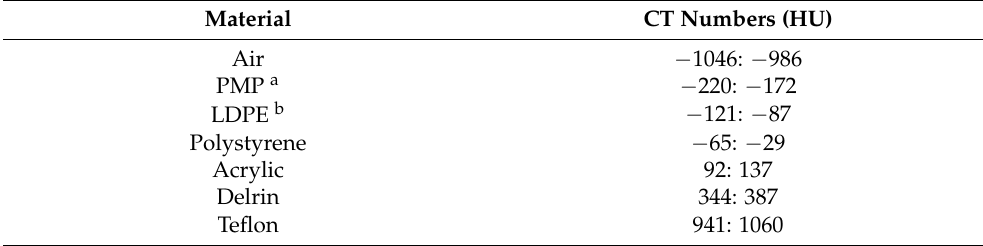
Table 1. Nominal CT numbers of the Catphan-CTP404 contrast objects